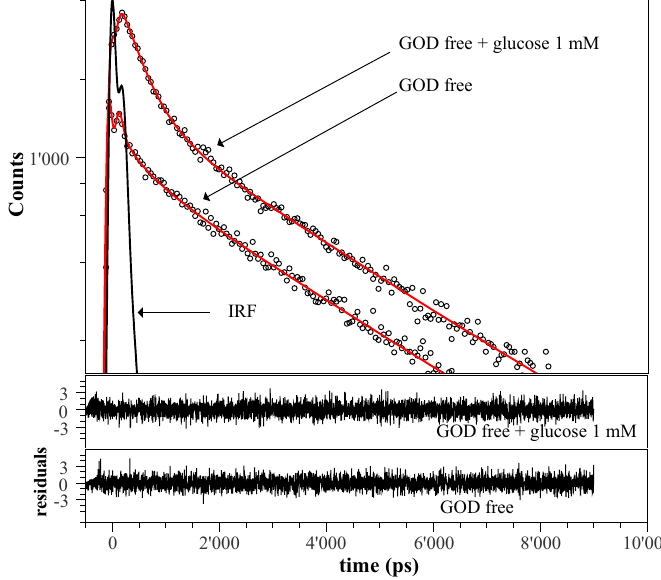
Figure 5. Black points represents the fluorescence decays for free GOD when excited in = 405 nm ) without and with glucose (1 mM). Red solid curves are the FAD region ( (cid:21) exc three-exponential fits. The instrument response function is shown for comparison with the fluorescence decay. In the lower panels residuals for three-exponential models are reported. The fitting parameters are shown in Table